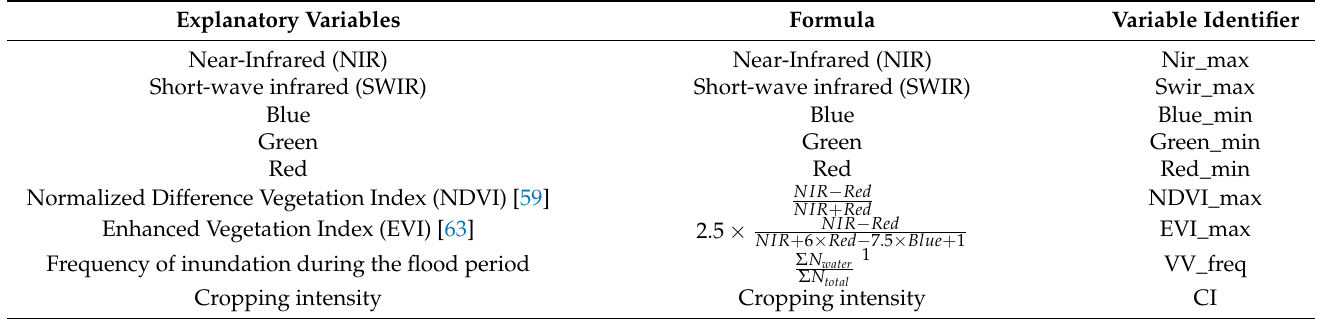
Table 1. Predictor data layers utilized by the Random Forest Classifier to classify pixels as recovered croplands and unrecovered